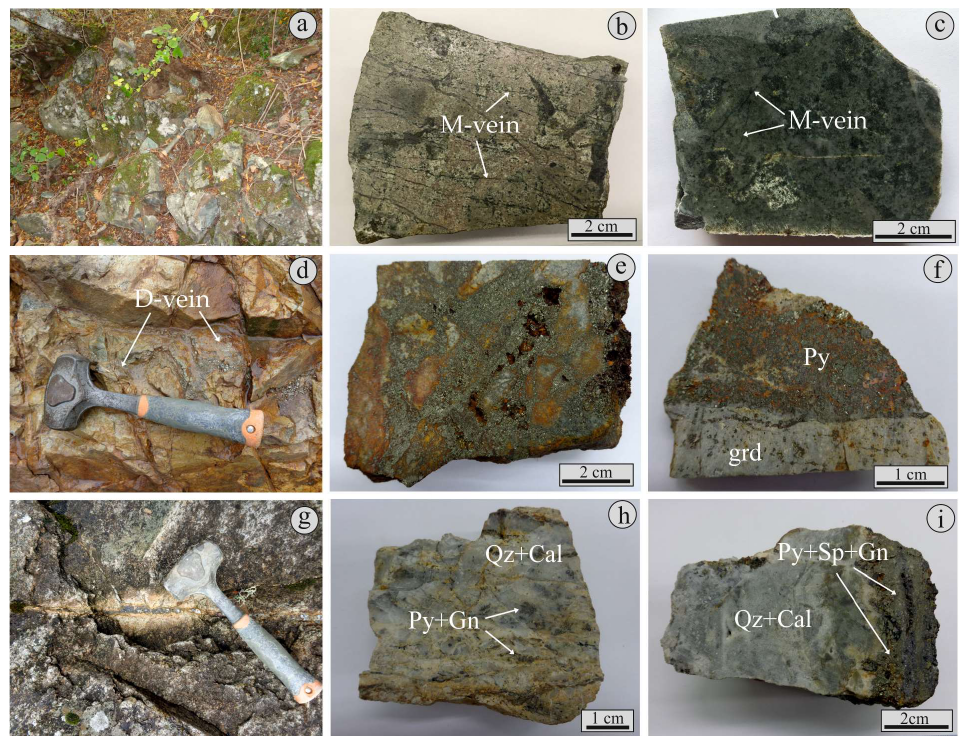
Figure 6. Field and hand-specimens photographs of pyrite-bearing rocks from the Pagoni Rachi porphyry/epithermal prospect: ( a ) Sodic/potassic-calcic altered granodiorite porphyry crosscut by magnetite veinlets; ( b , c ) Magnetite (M-type) veins crosscutting sodic/potassic-calcic altered granodiorite (samples KMPR74 and KMPR68, respectively); ( d ) D-type pyrite (py) vein crosscutting sericitic-altered granodiorite porphyry; ( e – f ) Massive pyrite vein (D-type), cementing fragments of sericite altered granodiorite porphyry, grd = granodiorite (sample KMPR66); ( g ) Epithermal-style vein with sphalerite and pyrite, crosscutting sericitic-altered (sericite and calcite) granodiorite porphyry; ( h , i ) Hand specimens of epithermal-style, clear to milky quartz (Qz) - calcite (Cal) veins (E-type) with pyrite (Py), sphalerite (Sp) and galena (Gn) (samples KMPR53 and KMPR83, respectively).